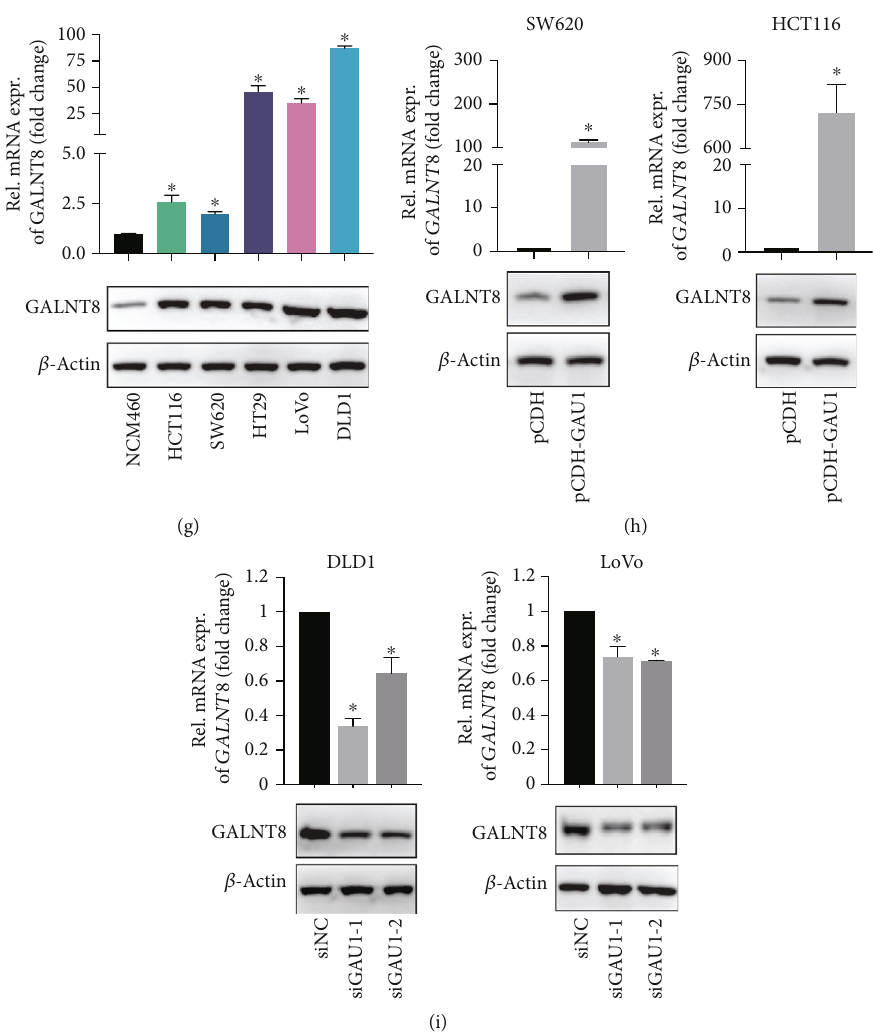
Figure 3: GALNT8 as the oncogenic operator of GAU1 in CRC. (a) Correlation analysis of GALNT8 and GAU1 in 184 TCGA CRC samples (Spearman rho = 0 : 67 , P = 2 : 44 × 10 − 23 ), and 66 frozen CRC tissues (qRT-PCR, R 2 = 0 : 41 , P < 10 − 4 ). (b) qRT-PCR analysis of GALNT8 expression level in 66 paired CRC tissues and adjacent normal tissues ( P < 10 − 4 ). N: adjacent normal tissues; T: tumor tissues. (c) Kaplan- Meier analysis of GALNT8 and overall survival in 66 CRC patients. (Kaplan-Meier P = 0 : 31 × 10 − 2 ). (d) Representative photomicrographs of GALNT8 in CRC specimen TMA (magni fi cation: × 100, × 400). (e) Two paired tumor-adjacent control representative cases of GALNT8 expression in the TMA (magni fi cation: × 100, × 400). (f) Kaplan-Meier analysis of GALNT8 expression and overall survival in 69 TMA samples. (Kaplan-Meier P = 2 : 38 × 10 − 2 ). (g) qRT-PCR and western blot analysis of GAU1 expression in the fi ve CRC cell lines and the normal NCM460 cells was tested. ∗ P < 0 : 05 . (h) qRT-PCR and western blot analysis of GALNT8 expression level in GAU1 -overexpressed SW620 and HCT116 cells, as well as (i) GAU1 -knockdown DLD1 and LoVo cells. ∗ P < 0 : 05